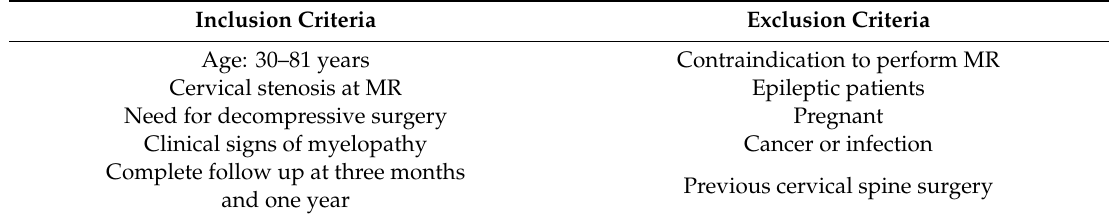
Table 1. Inclusion and exclusion criteria.